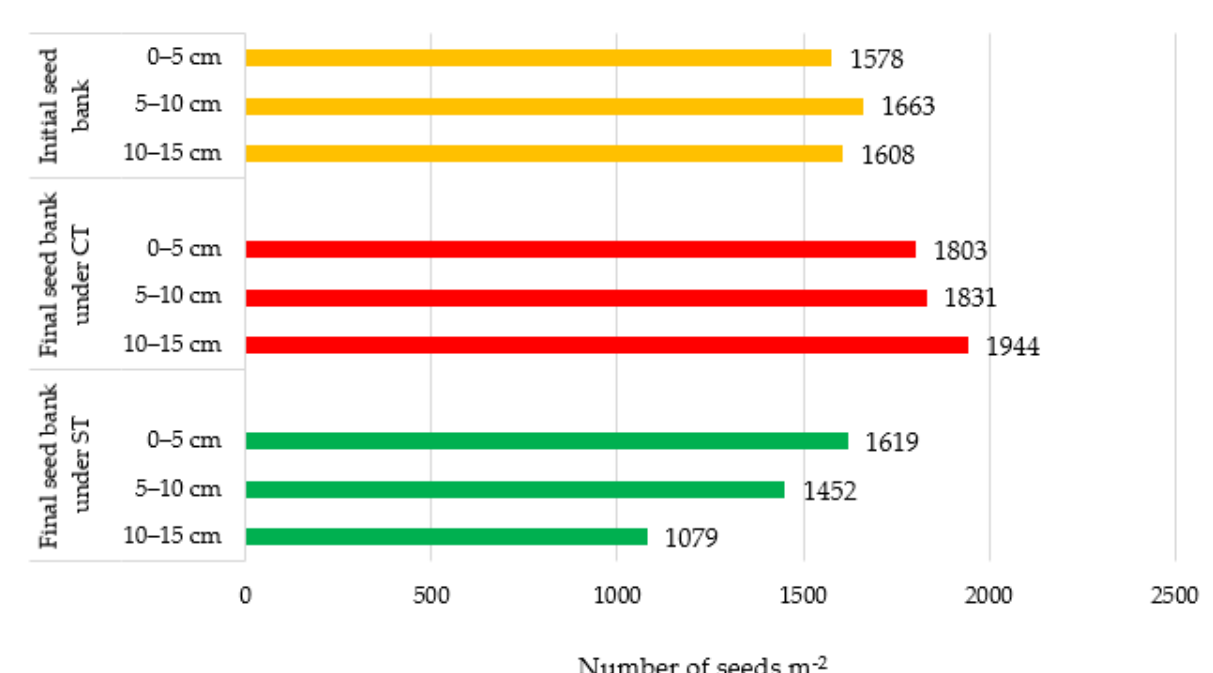
Figure 5. Vertical distribution of seeds at 0–5, 5–10, and 10–15 cm soil depth under mulched and non-mulched conditions (mean from two crop rotations). 4. Discussion In our study, the seed bank exposed to CT + no-residue for six crops over 2 years had a higher number of broadleaves, grass, and sedge weeds than the seed bank exposed to ST + 50% for 2 years. This was attributed to weed species suppression after continuous ST